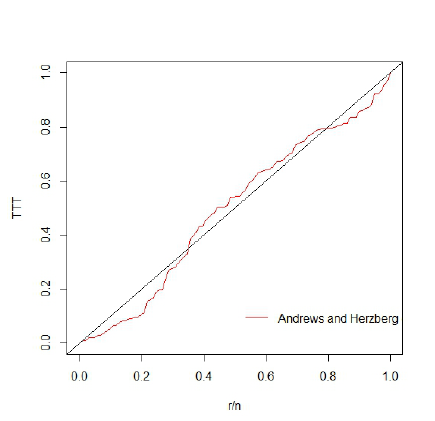
Figure 3 – TTT Plots of Andrews and Herzberg data. Plots of the estimated PDF and CDF of the EEW, EW, W, EGE, GE and